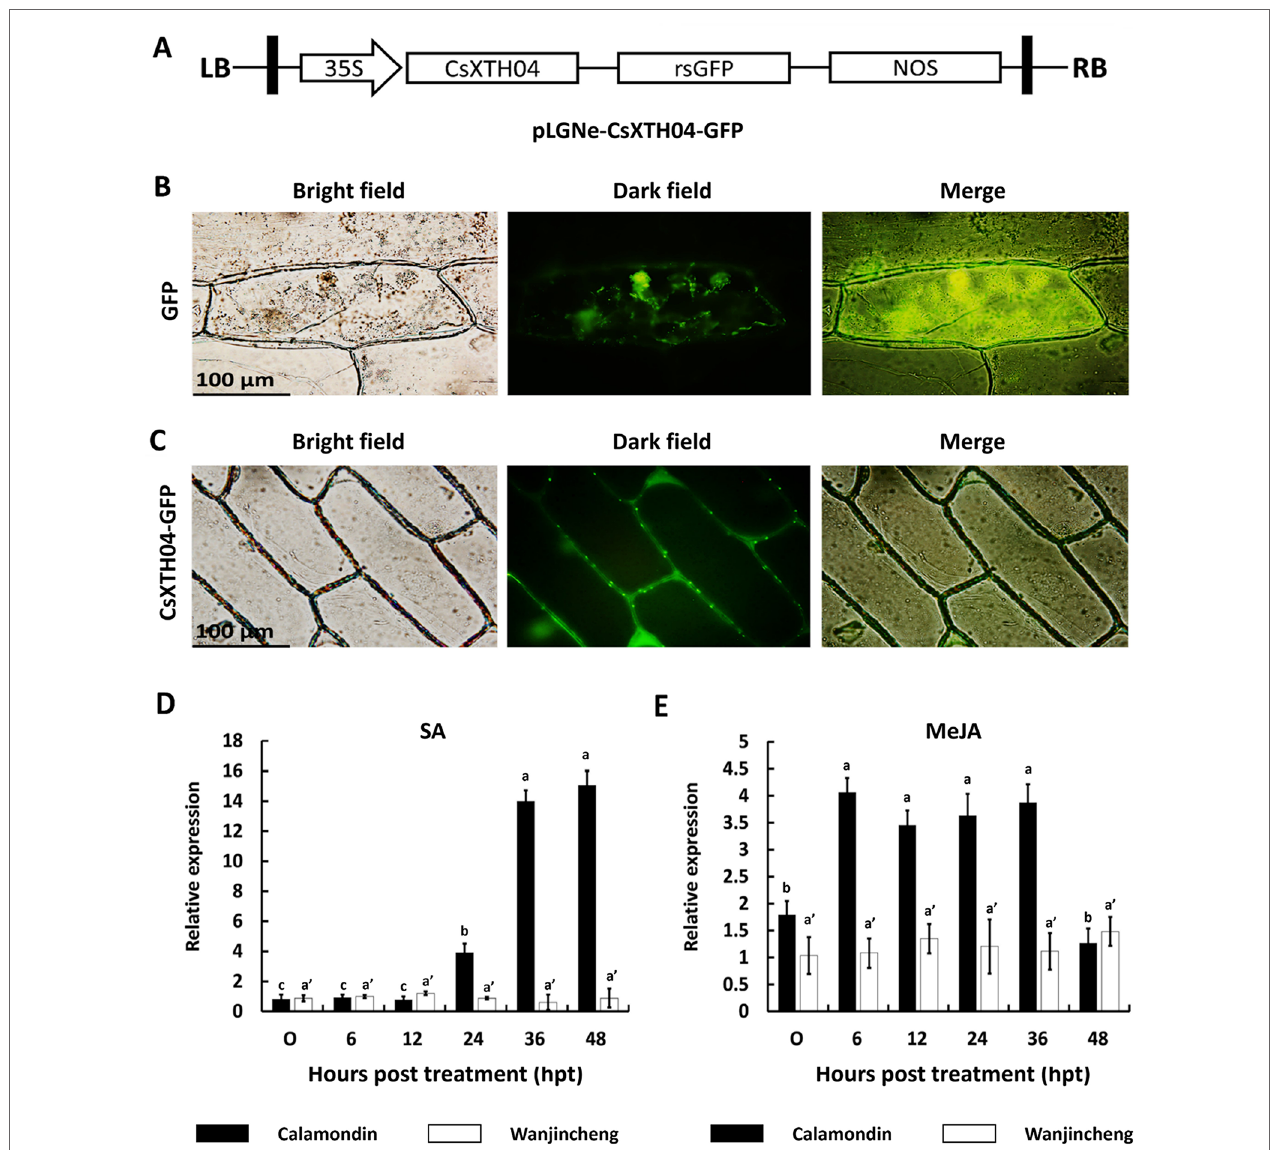
FIGURE 4 | Subcellular localization and SA/MeJA inducible expression profiles of CsXTH04. (A) Structure of the transient expression plasmid (pLGNe-CsXTH04- GFP). LB, left border; RB, right border; 35S, CaMV35S promoter; NOS: terminator. (B) Transient expression of GFP. (C) Transient expression of CsXTH04-GFP. Each field of view is displayed as a bright field, dark field, and merged image. Expression of CsXTH04 induced by SA (D) and MeJA (E) was measured by qRT–PCR and normalized to CsActin. Samples were collected at 0, 6, 12, 24, 36, and 48 hpt with SA and MeJA. In (B) and (C) , scale bars = 100 μm. In (D) and (E) , solid bars represent calamondin, while empty bars represent Wanjincheng. Results were analyzed via Tukey’s honestly significant differences ( P = 0.05) in three biological replicates. Each value represents the mean ± SD. For (D) a = 0.213, b = 1.000, c = 0.979, a' = 0.597. (C) a = 0.702, b = 0.380, a' = 0.845. GFP, green fluorescent protein; MeJA, methyl jasmonate; qRT–PCR, quantitative reverse transcriptase–polymerase chain reaction; SA, salicylic